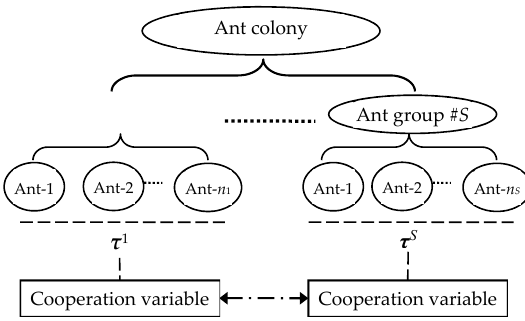
Figure 2. The grouping operation and cooperative framework of coevolution ACO (coACO).